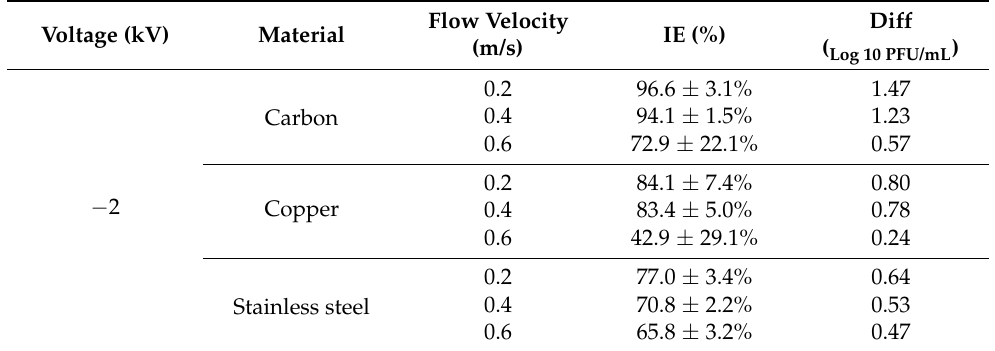
Table 3. Inactivation efficiency (%) and logarithmic difference of the aerosolized MS2 bacteriophages for each material and flow